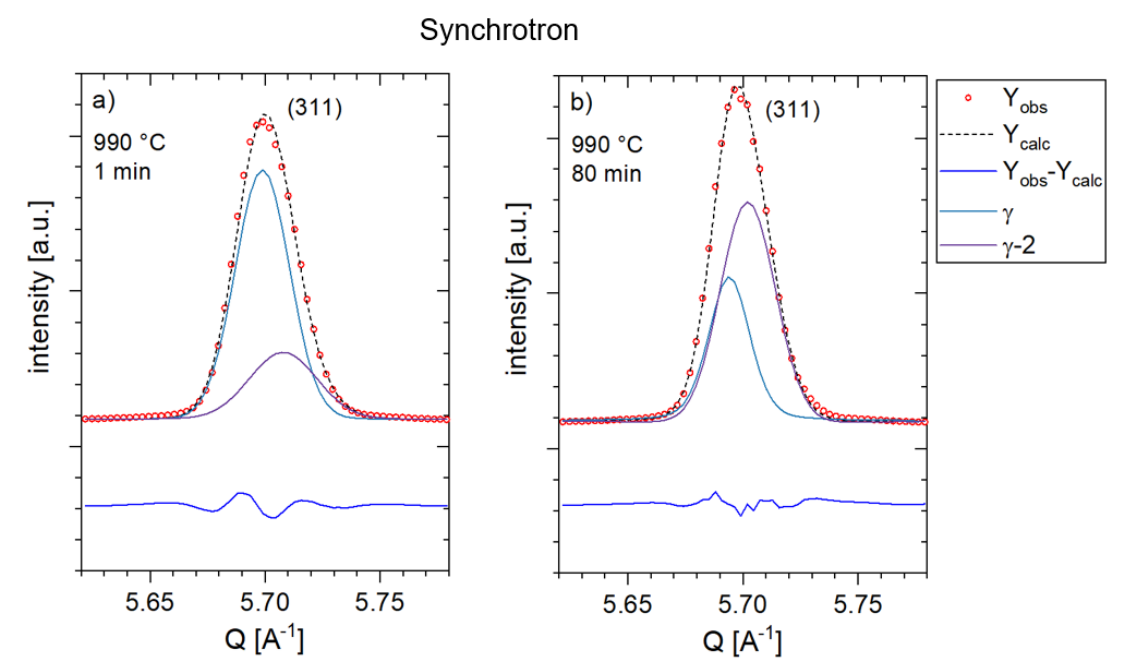
Figure 6. Detailed view of Rietveld refinement ( a ) at the beginning (t = 1 min) and ( b ) at the end of the third holding segment (t = 80 min) at 990° of the (311) diffraction peaks: observed data (red circles), calculated data (black line), and difference plot (blue line). In these diffractograms, the simulated patterns of the γ and γ-2 phase are also shown.